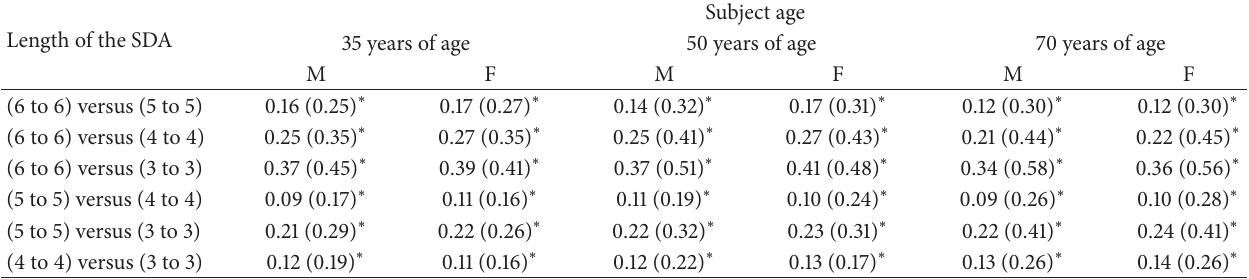
Table 3: Mean difference and standard deviation of the mean difference for paired 𝑡 -test to examine the impact of arch length on dentists’ attitudes towards